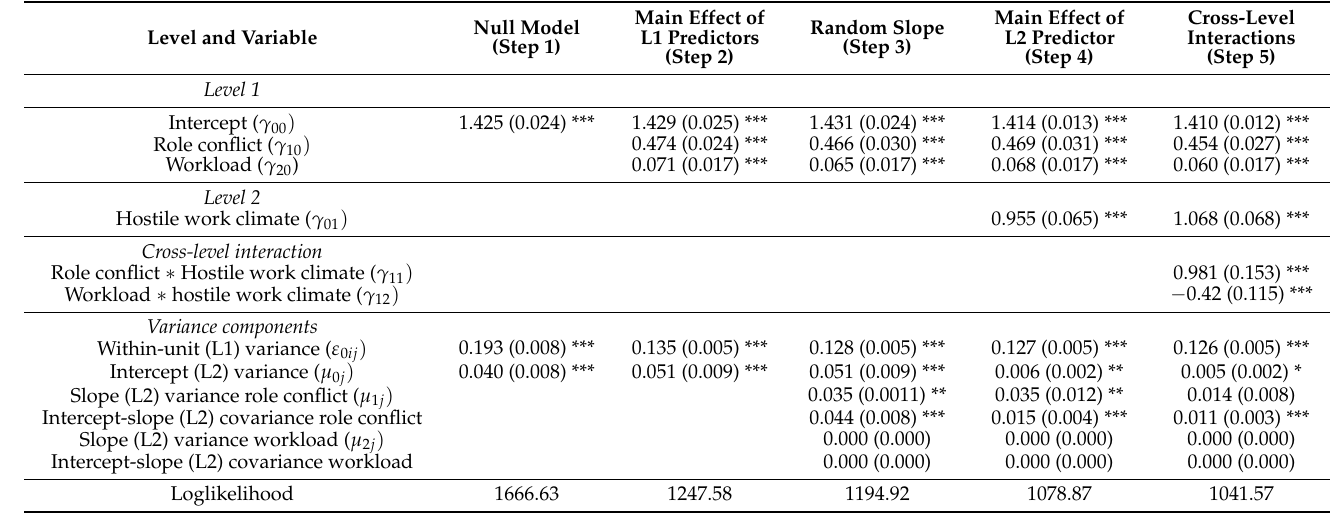
Table 2. Multilevel estimates for the prediction of bullying behaviours.